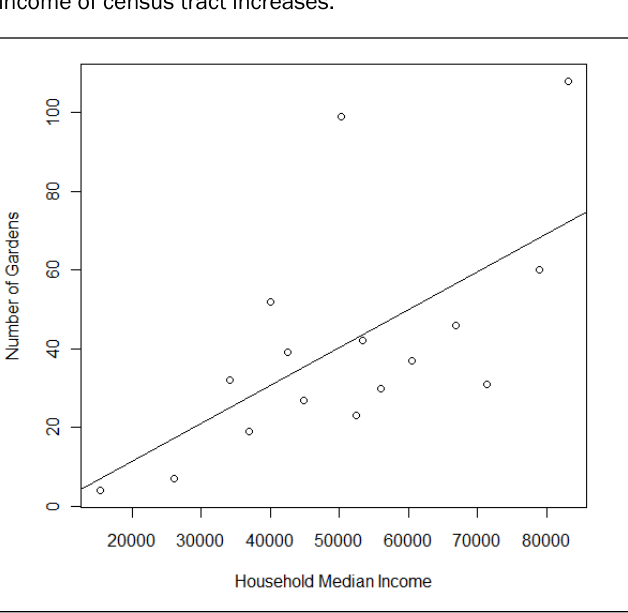
Figure 6. Scatter Plot and Fitted Line of Garden Presence as a Product of Tract-Level Median Household Income Home garden presence increases as household median income of census tract